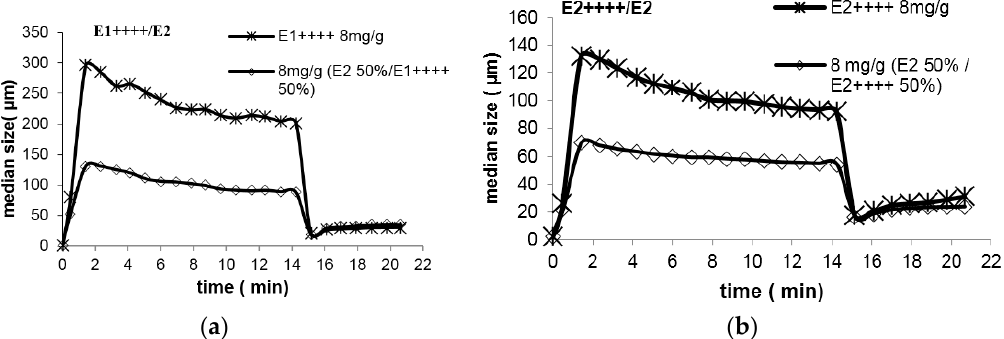
Figure 2. Re-flocculation with mixture (8 mg/g PCC) of branched and linear polymer (50/50% weight) added simultaneously at the beginning of flocculation: ( a ) E1++++/E2 and ( b ) E2++++/E2.